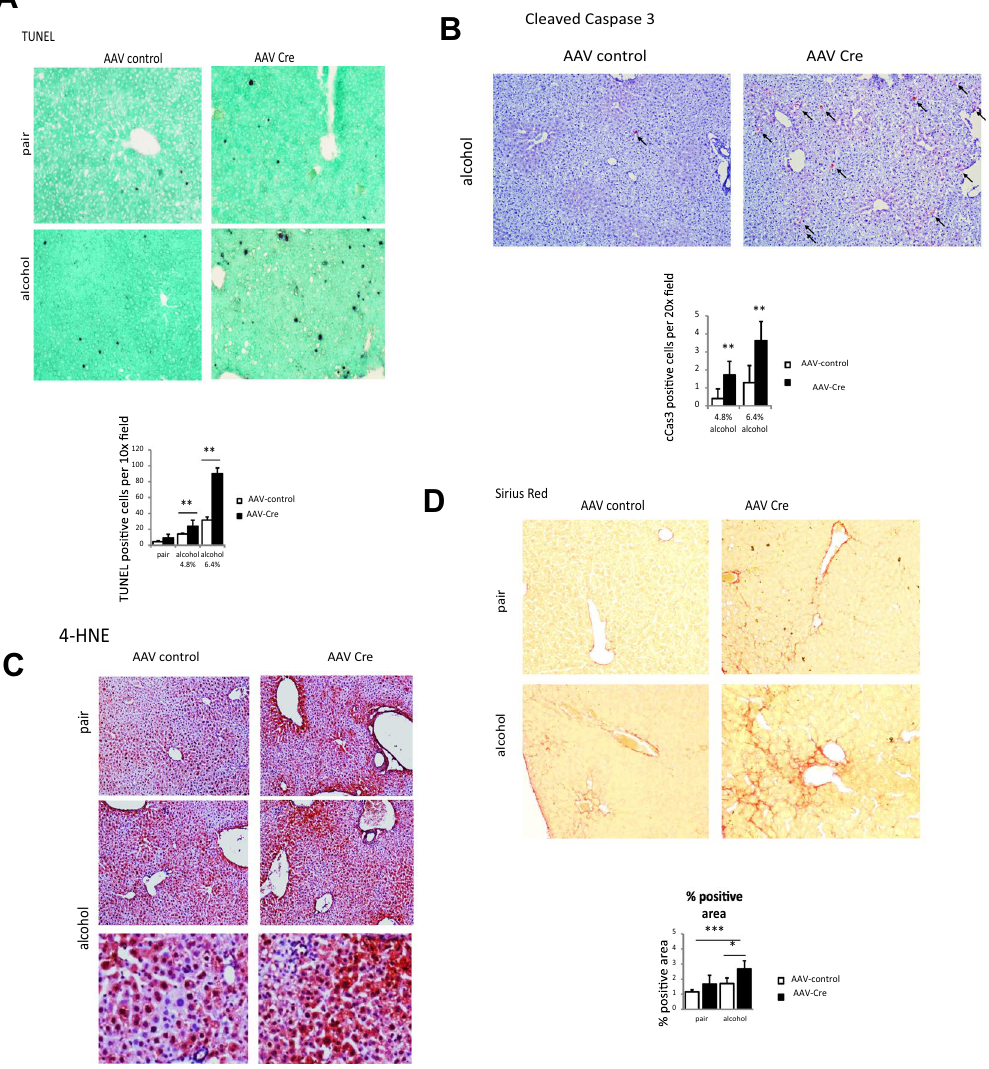
Figure 2. PRMT1 protects liver from oxidative stress and hepatocyte death. ( A ) Representative images of TUNEL staining. Diagram below shows number of positive cells per low magnification field. Data are presented as mean ± SD, N = 3–4 mice per group, ** p < 0.01; (B) Representative images of immunohistochemistry staining using anti-cleaved Caspase 3 antibodies. Diagram below shows average number of positive cells per field. Data are presented as mean ± SD, N = 3–4 mice per group, ** p < 0.01. ( C ) Representative images of 4-HNE staining in livers of the mice as in Fig. 1A. ( D) Representative images of Sirius Red staining. Diagram below shows average %positive area. Data are presented as mean ± SD, N = 3–4 mice per group, * p < 0.05, *** p <